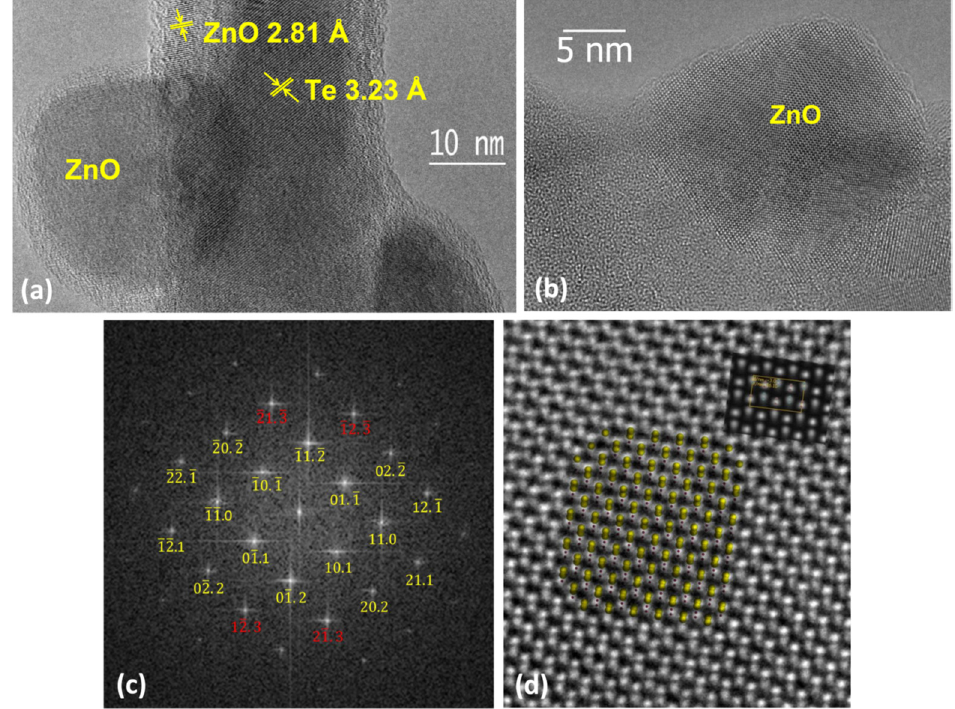
Figure 4. The TEM analysis of the structure of the oxidized ZnTe NW, similar to these presented in Figures 1b and 2a. Panels ( a ) and ( b ) zoom in these areas of the NWs in which the large crystallites are formed. The distance markers in (a) represent the dominant interlayer spacings in the core and the edge parts of the NWs. ( c ) 2D Fourier transform obtained for ZnO crystallite seen in ( b ). ( d ) High-resolution TEM image taken in (cid:4670)1(cid:3364)1.1(cid:4671) zone axis of a small fragment of the same crystallite. The simulated image (right top inset) and ball model of projection of ZnO wurtzite structure are superimposed.